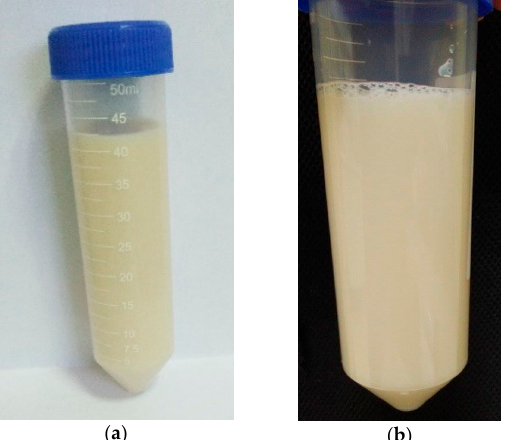
Figure 1. ( a ) Nanostructured lipid carrier incorporated with Ficus deltoidea (FDNLC) and ( b ) blank dispersions of nanostructured lipid carrier (without Ficus deltoidea ).